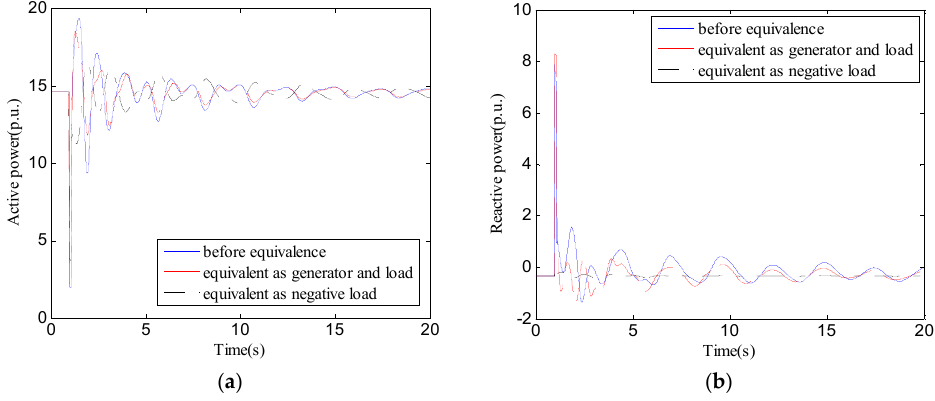
Figure 8. ( a ) Active power curves about different model; ( b ) reactive power curves about different model. Table 3. Parameters of equivalent model (p.u).